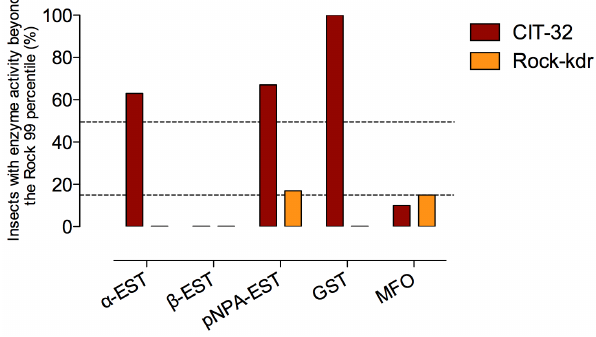
Figure 1. Activity of enzymes related to insecticide metabolic resistance in Aedesaegypti strains. The cut-offs are (dashed lines) determined by the Rockefeller 99 percentile value of each enzyme (see [11]). Rockefeller is a reference strain of insecticide susceptibility and vigor. Distributions with less than 15% of individuals beyond the cut-off are considered unaltered. Between 15 and 50% are altered and above 50% are highly altered. CIT-32 is the original kdr strain, derived from a pyrethroid resistant Brazilian Aedes aegypti population. Rock-kdr is the kdr strain, backcrossed for eight generations with Rockefeller in order to reduce the contribution of detoxification enzymes to pyrethroid resistance.